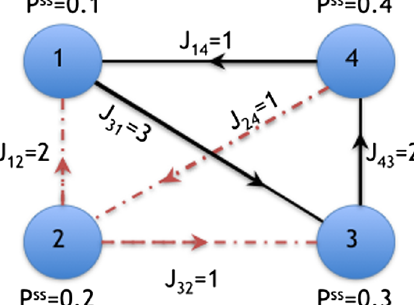
FIG. 2. A concrete example of a NESS for which we build an equivalent stochastic pump. In this example, R ij ≠ 0 for all i , j . The spanning tree was chosen to be the 2-1, 2-3, and 2-4 edges (dashed red lines), and the fundamental currents are the currents along the 1-4, 1-3, and 3-4 edges (solid black lines). In this system, there are two current loops: 1 → 3 → 4 → 1 and 2 → 3 → 4 → 2